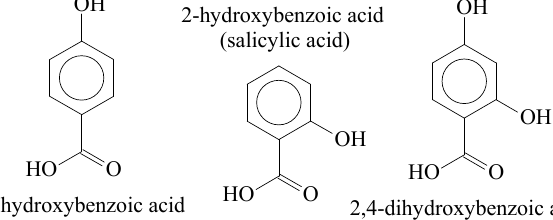
Figure 3. Aromatic molecules with hydroxyl and acid groups.